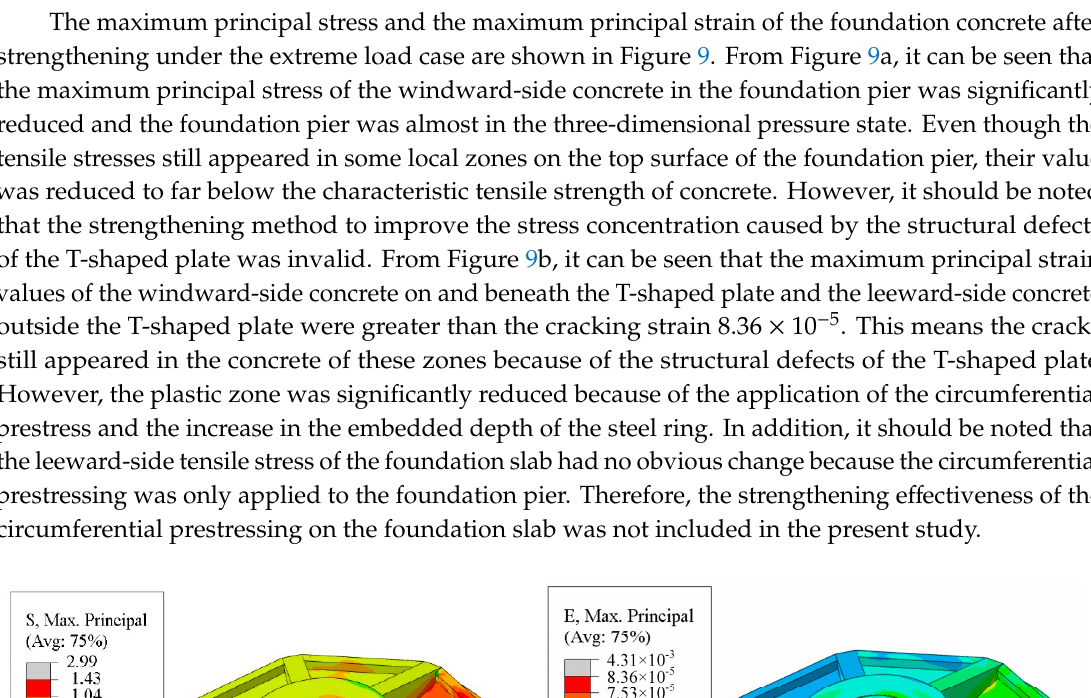
Figure 8. Maximum principal stress and strain of foundation concrete before strengthening under the extreme load case. ( a ) Maximum principal stress; ( b ) Maximum principal strain.